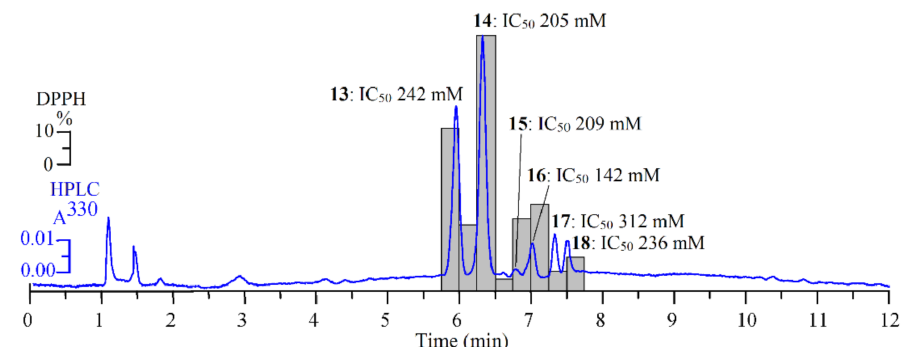
Figure 5. DPPH · free radical inhibiting activity of HPLC fraction of S. repens leaves SPE-2 fraction (Control 1 sample). The grey bars showed the antioxidant activity (as percentage) in probe after reaction with DPPH · solution. The HPLC-PDA profile of S. repens leaves SPE-2 fraction is a blue chromatogram with active compounds numbered as 13 —schaftoside-2 (cid:48)(cid:48) - O -glucoside (sileneside E); 14 —schaftoside; 15 —isovitexin-2 (cid:48)(cid:48) - O -glucoside (meloside A); 16 —isovitexin; 17 —swertisin-2 (cid:48)(cid:48) - O - glucoside; 18 —swertisin. The value of IC 50 for the separate compounds displayed with the number of corresponding